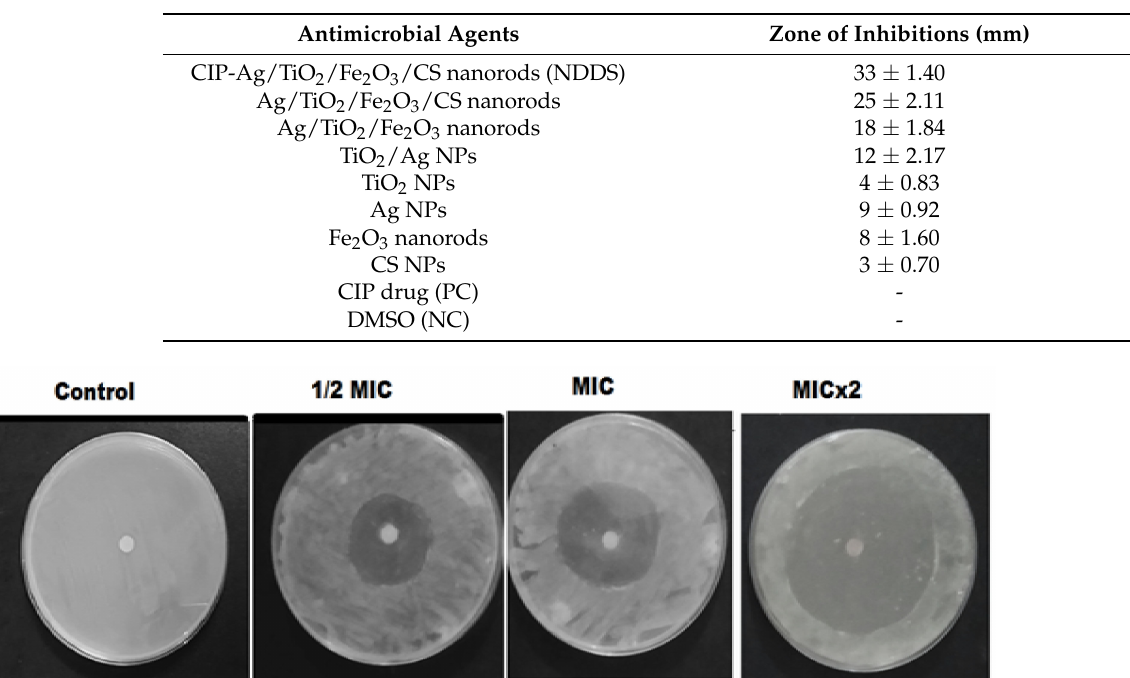
Table 1. Zone of inhibitions of biosynthesized nanomaterials were recorded at respective MICs against MDR E. coli . CIP and DMSO were used as positive and negative controls, respectively. Antimicrobial Agents